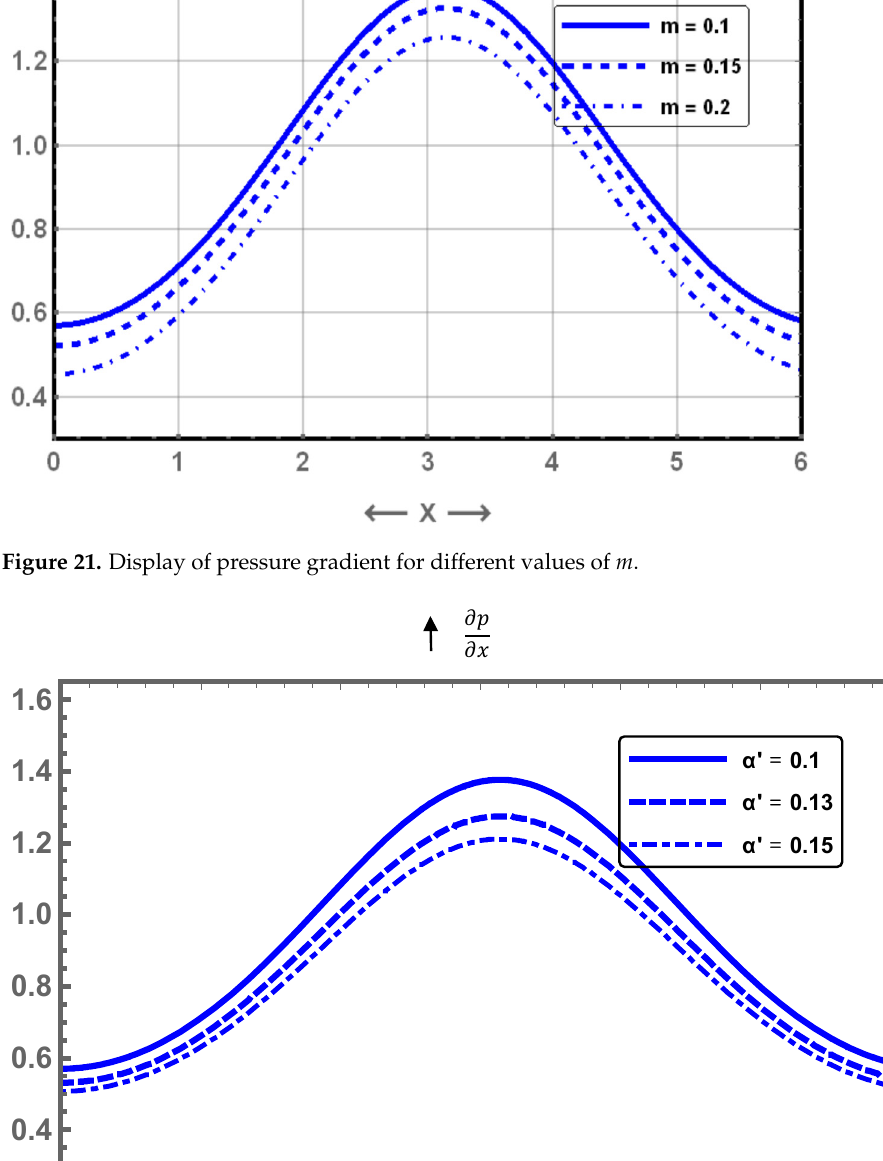
Figure 22. Display of pressure gradient for different values of 𝛼 (cid:4593) .